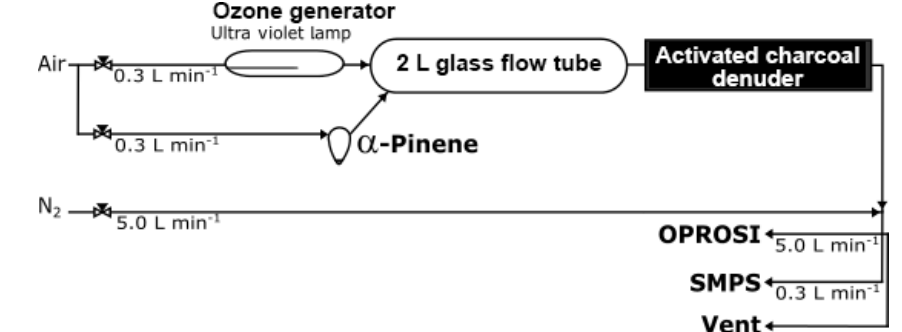
Figure 5. Experimental set-up to produce and measure varying concentrations of oxidised secondary organic aerosol (SOA) via ozonolysis of α -pinene. An ozone-generating lamp was used to enable generation of α -pinene SOA in the flow tube. The exposure of the lamp was adjustable with an internal UV shield, enabling a range of aerosol masses to be measured and tested for ROS concentration.